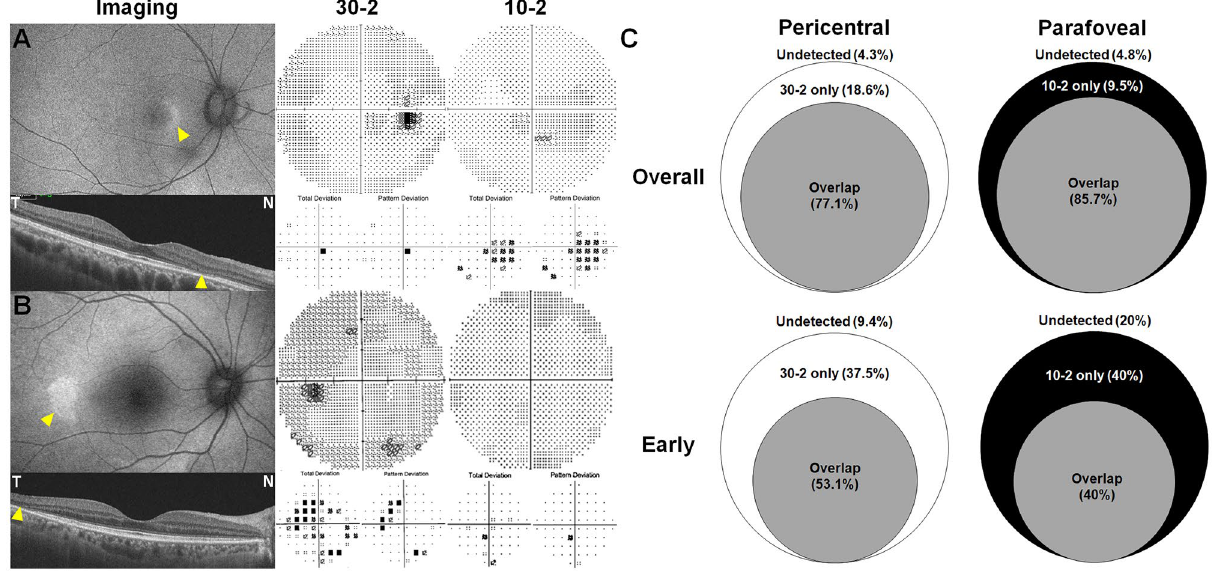
Figure 3. Examples of visual field (VF) results showing disparity in abnormality between 10-2 and 30-2 tests in eyes with ( A ) parafoveal and ( B ) pericentral retinopathy, and ( C ) Venn diagram showing disparity between the tests. ( A ) In the eye with parafoveal retinopathy, the 30-2 test shows an ambiguous finding, whereas the 10-2 test shows a temporal patchy scotoma. ( B ) In the eye with pericentral retinopathy, the 30-2 test shows a partial-ring scotoma, while the 10-2 test plots are essentially normal. The yellow arrowheads indicate abnormal findings on fundus autofluorescence (FAF, top left) and optical coherence tomography (OCT, bottom left) imaging. ( C ) Percentage of eyes classified as having an abnormal VF with the 30-2 (white) and 10-2 (black) tests for each retinopathy pattern among overall and early cases. Gray indicates those with the same results (overlap) between the 10-2 and 30-2